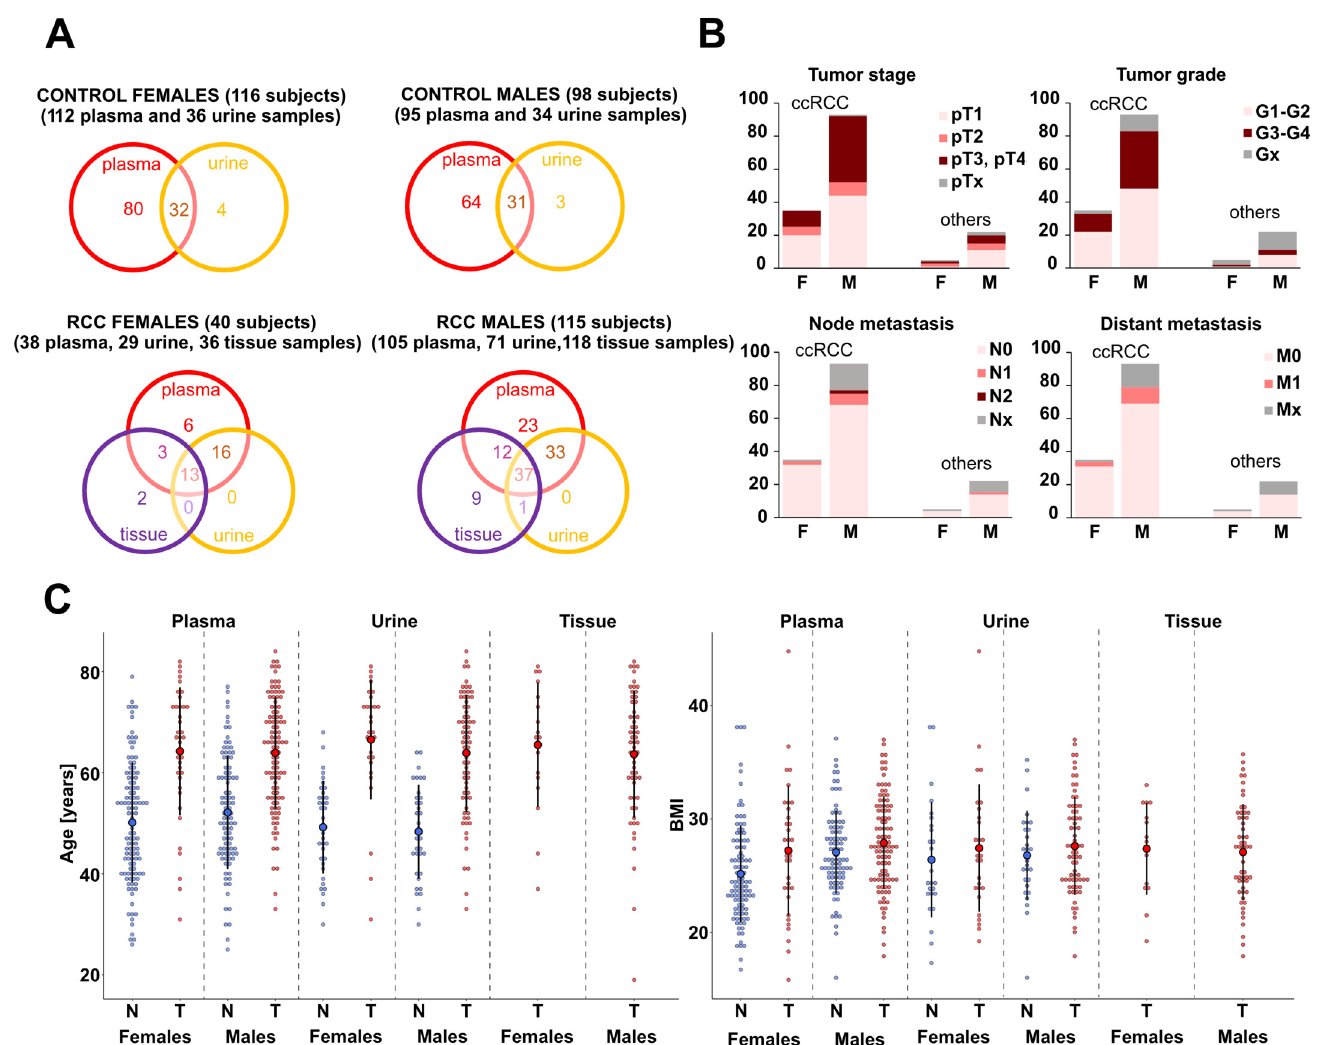
Figure 1. Overview of number of samples and clinical information. ( A ) Venn diagrams showing the number of individual plasma, urine, and tissue samples obtained from control volunteers and kidney cancer patients (separately illustrated for females and males). To obtain the number of tissue samples, it is necessary to multiply the numbers in the purple circles by two, as both tumor and nontumor types of tissue were obtained from each patient. ( B ) Stacked bar charts reflecting the TNM tumor classification [24] of cancer patients. The graphs show the number of patients grouped by individual tumor stage, tumor grade, and type of node and distant metastases, separately shown for males (M) and females (F) (see Supplementary Data S1 for more details). The first two bar charts represent ccRCC patients and the other two represent patients with other kidney cancer types. ( C ) Dot plots illustrating the age and BMI distribution of control volunteers (N, blue dots) and cancer patients (T, red dots) in the case of plasma, urine, and tissue